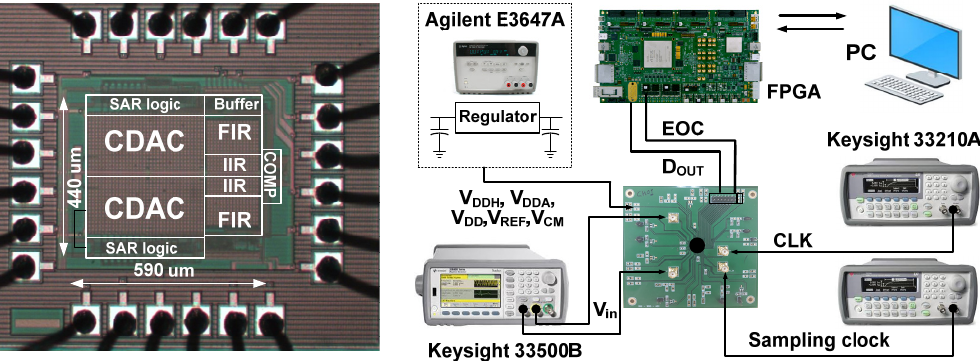
Figure 12. Microphotograph of the fabricated ADC. Measurement setup is also shown.